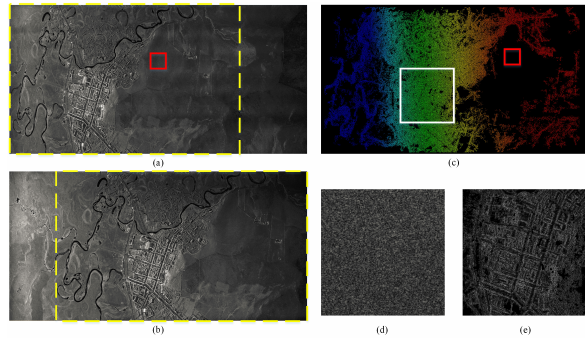
Figure 7. Matching result of the line array image, where (a) and (b) are the base and matching images of the stereo pair from ADS40; (c) is the result of (a) and (b) (coloring by parallax, red represents a large parallax, and blue represents a small parallax); (d) is the enlarged view of the area in the white rectangle of (c) shown in 3D; (e) and (f) are the base and matching images of the stereo pair from GeoEye-1; (g) is the result of (e) and (f) (the coloring is the same as (c)); (h) is the enlarged view of the area in the white rectangle of (g) shown in 3D. SAR Image : The imaging apparatuses of SAR differ from those of an optical image. Repeated texture appears frequently on SAR images (as shown in Figure 8(d)). The scale of a SAR image changes along with the distance between the target and the nadir point of the sensor. In other words, the size and the shape of an object differ on stereo (which can be shown by the different sizes of the dashed box in Figures 8(a) and (b)), and the corresponding information is therefore difficult to be found. Figure 8(c) shows the parallax changes from left to right, which are correct according to the imaging apparatuses of SAR.